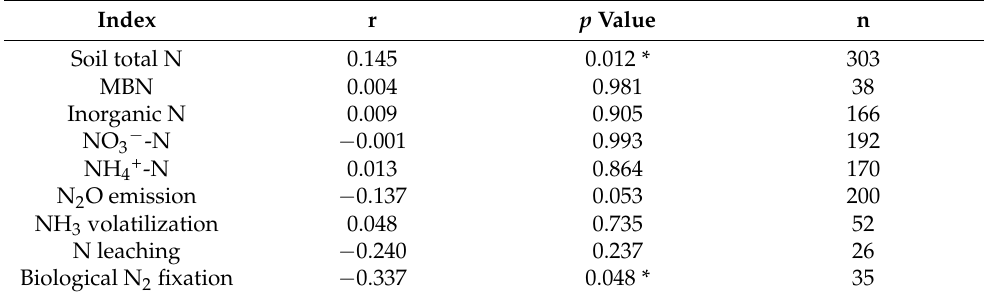
Table 1. Pearson correlation coefficients ( r ) between the response ratios (Equation (1)) of crop productivity and soil nitrogen (N) dynamic parameters. The “n” represents sample size. * represents the significance levels of p < 0.05.